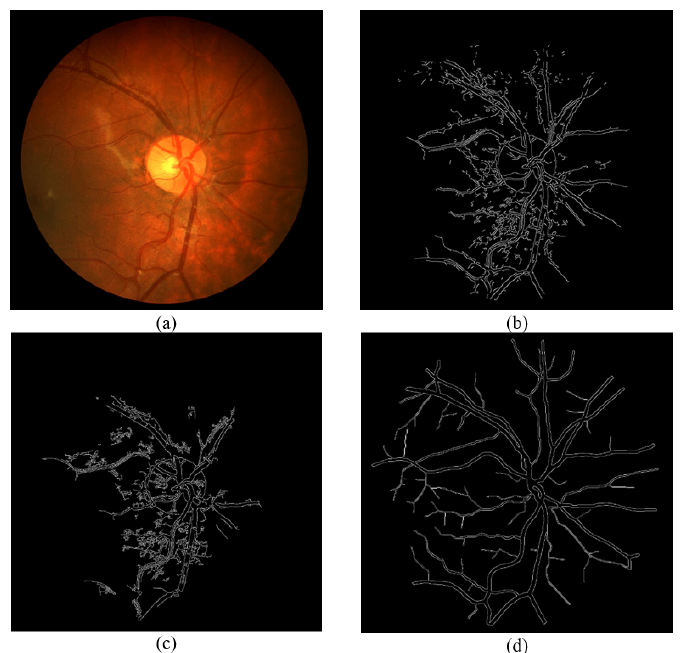
Figure 20. Comparison of segmented images for Image_01R.jpg from the CHASE_DB1 dataset. ( a ) Input image. ( b ) Segmented image using the proposed approach (GUI based) (the obtained PFOM value is 0.5208). ( c ) Segmented image using Canny detector with ideal parameters (i.e., low threshold is set at 6, and high threshold is set at 60) (the obtained PFOM value is 0.3664). ( d ) Ground truth image from the CHASE_DB1